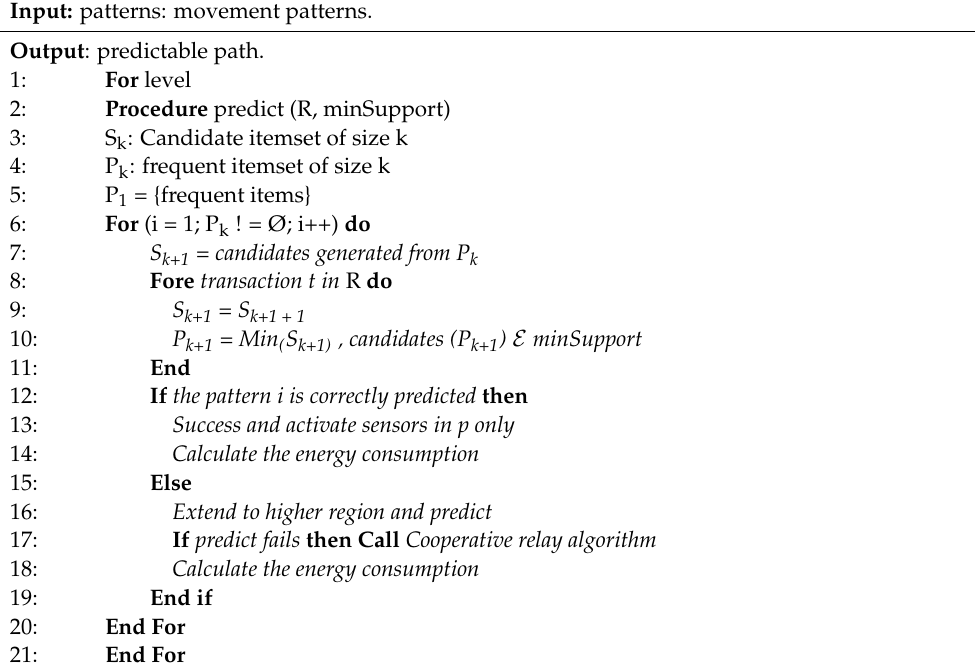
Algorithm 2: movement predicting the future location of a moving object